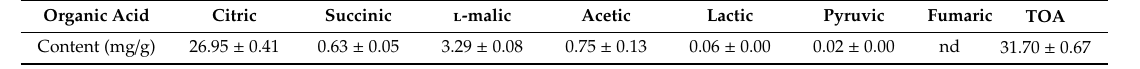
Table 5. Organic acids in hawthorn